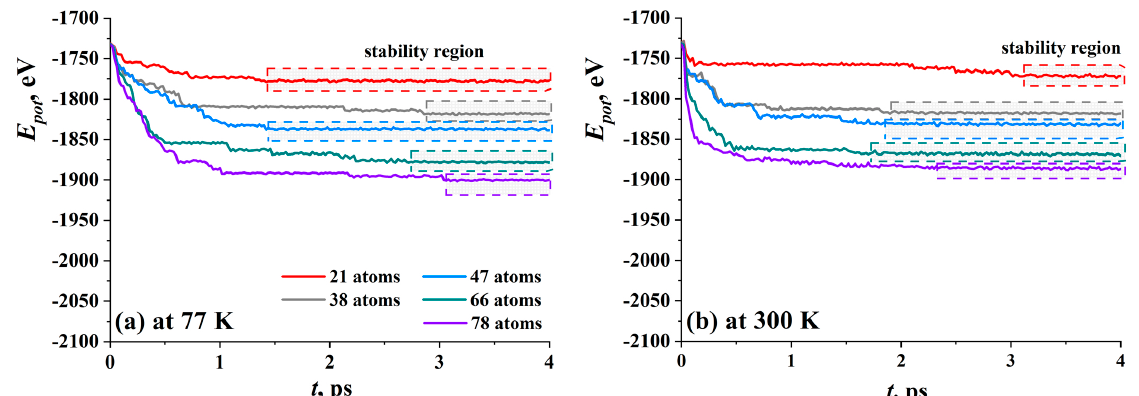
Figure 5. Potential energy as the function of exposure time at 77 K ( a ) and 300 K ( b ) for five types of hydrogen